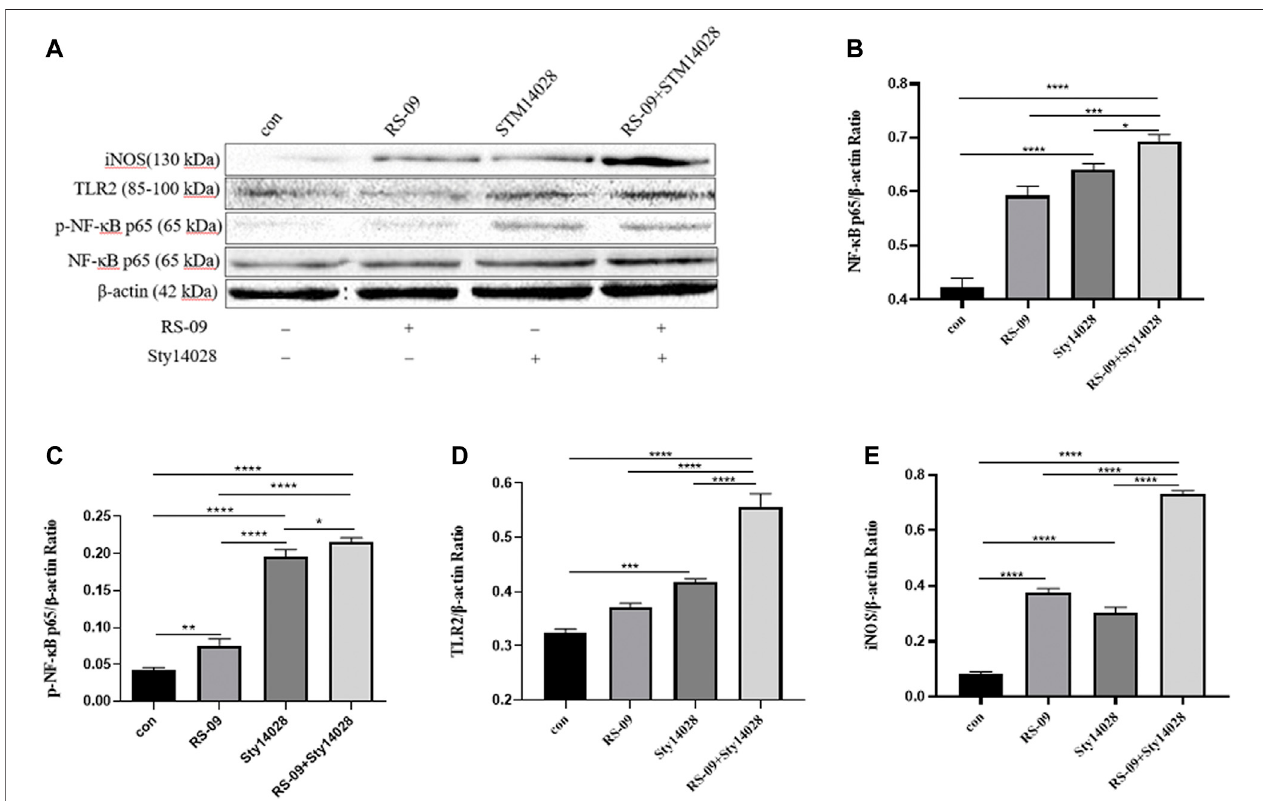
FIGURE 9 | RS-09 promotes the expression of NF- κ B in M1-type macrophages. Raw264.7 cells were stimulated with RS-09 alone, Sty14028 alone, or both RS- 09 and Sty14028 for 12 h. (A) Levels of iNOS, TLR2, p-NF- κ B and NF- κ B were detected using Western blotting (B – D) The quanti fi ed values of NF- κ B, p-NF- κ B, TLR2 and iNOS (E) expression in RAW264.7 cells were determined during 12 h of incubation. The image grey value was analysed using AlphaEaseFC software (Alpha Innotech, CA, United States). All values are expressed as the means ± S.D ( n = 3). * p < 0.05; ** p < 0.01; *** p < 0.001; **** p < 0.0001.